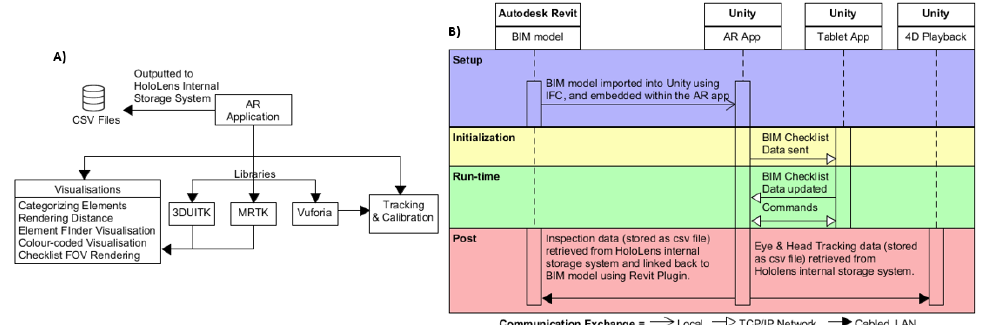
Figure 3. These diagrams present the system architecture of the BIM-ARDM system. The UML diagram ( A ) presents an overview of the primary components integrated into the AR application. The sequence diagram ( B ) demonstrates how the main components within BIM-ARDM